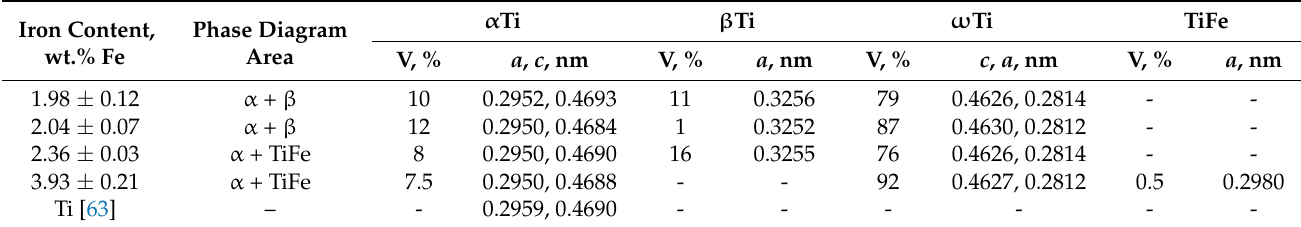
Table 2. Lattice parameters, phases and their volume fraction in alloys after heat treatment and HPT. Iron